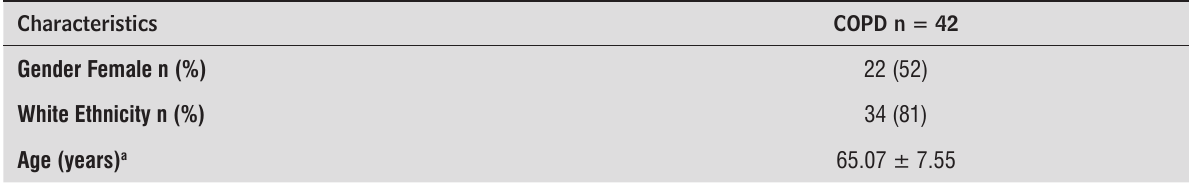
Table 1 - Clinical characteristics and education of patients with COPD, staging of COPD, comorbidities and treatments